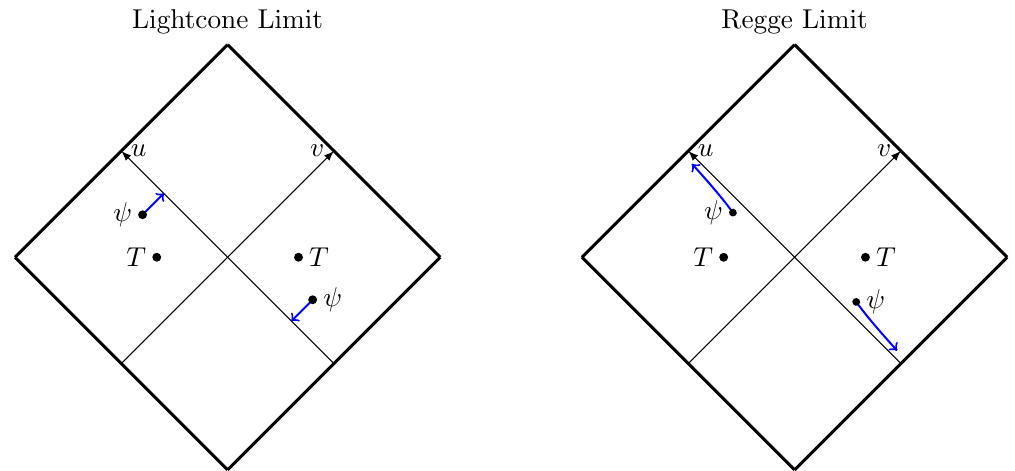
Figure 1 . The lightcone limit is v general, these limits do not